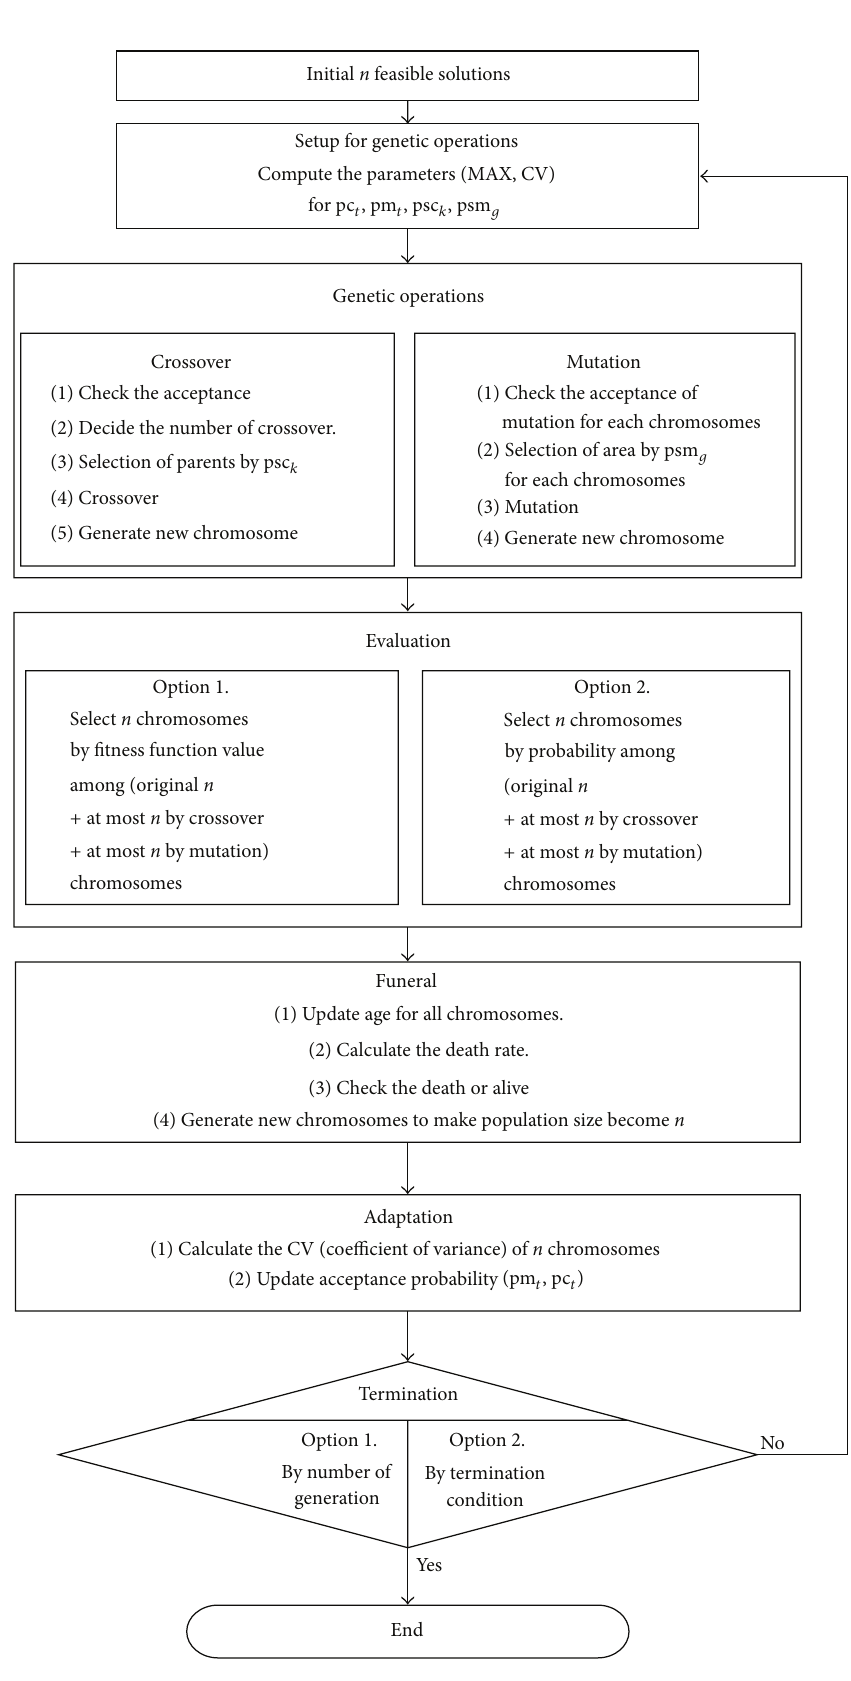
Figure 1: Procedure of the adaptive evolutionary